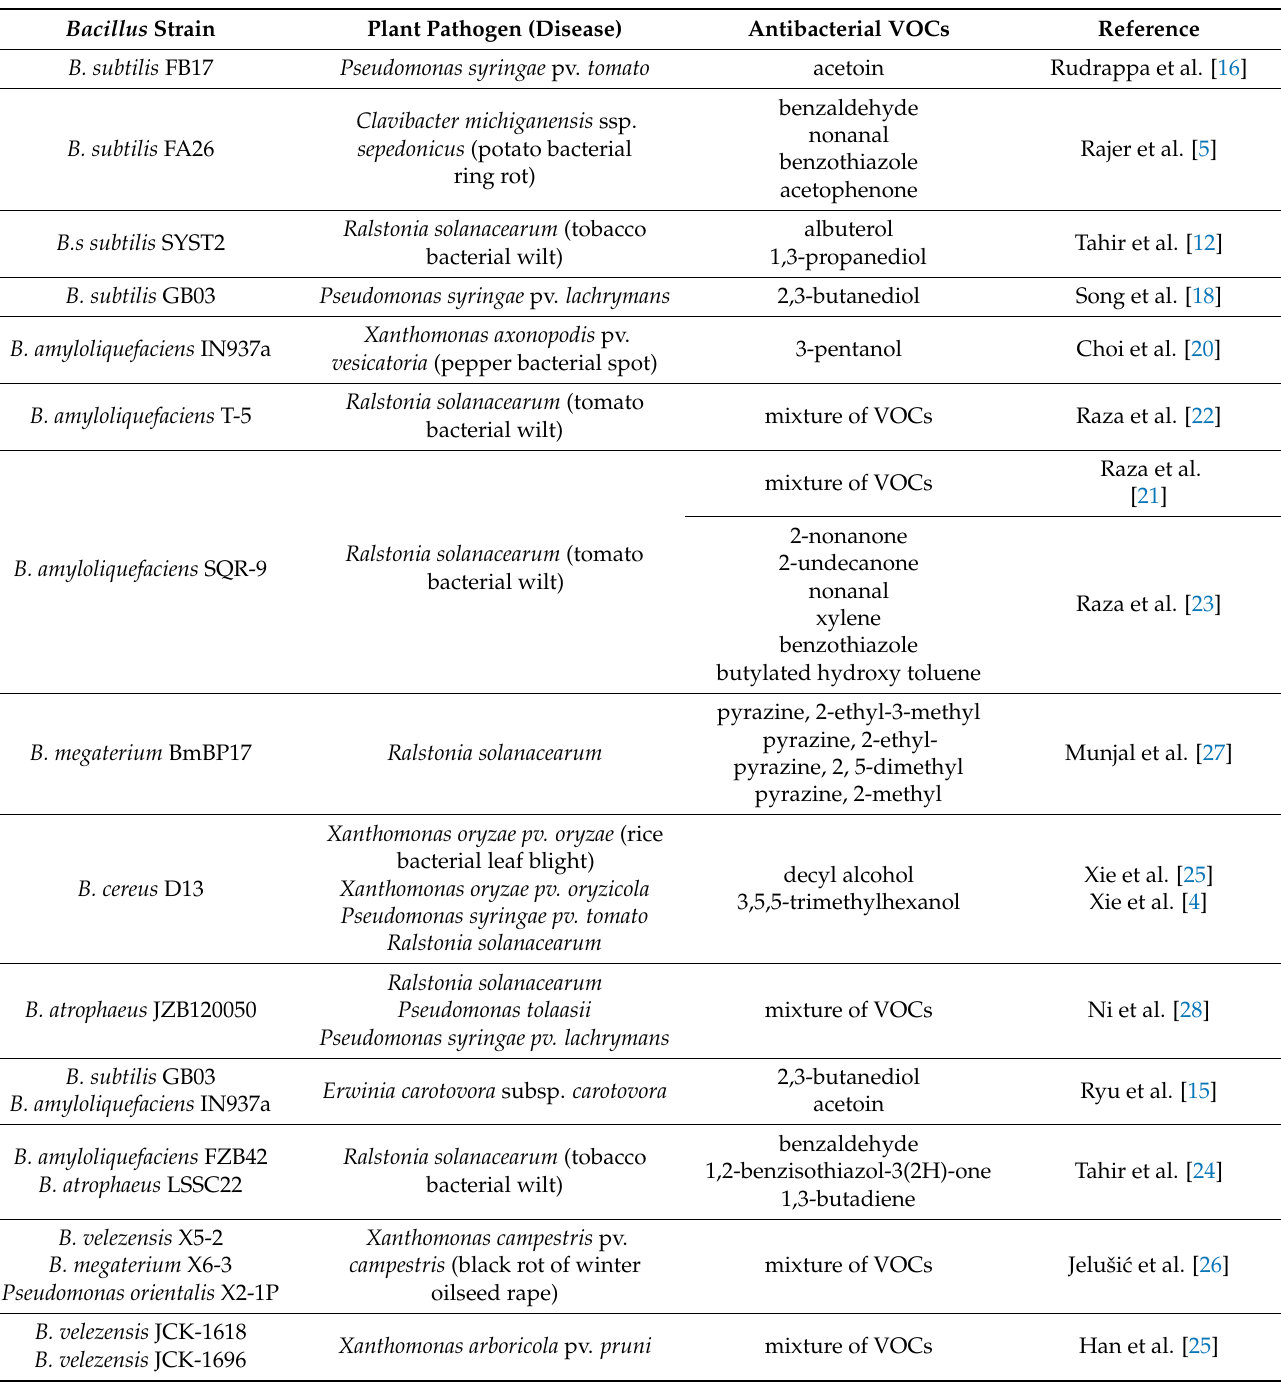
Table 1. Literature overview concerning VOCs exhibiting antibacterial activity against plant pathogens produced by Bacillus